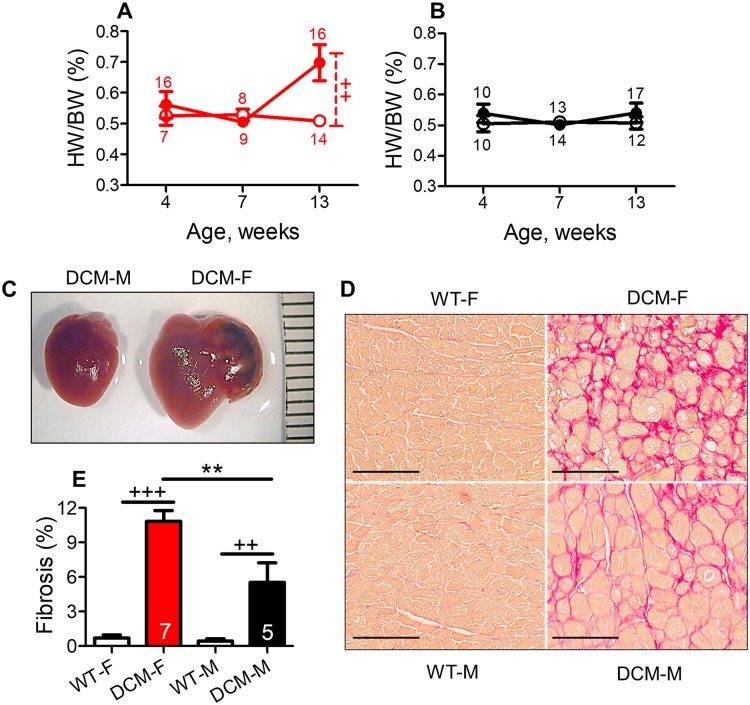
Sex differences in cardiac fibrosis and hypertrophy in DCM mice.(A) Heart weight to body weight ratio (HW/BW%) in female and (B) in male DCM and WT mice. Female or male mice with DCM are indicated by closed symbols, female or male WT controls mice by open symbols. Number of animals per group at each time point is shown. (C) Representative (scale bars, mm) image shows gross heart morphology of female and male mice with DCM at the age of 13 weeks. (D) Representative picrosirius red-stained images (scale bars, 100 μm) show collagen from heart tissue of DCM and WT, female and male mice of 13 weeks of age. Red color indicates collagen deposition. (E) Interstitial percent fibrosis was calculated in measurements from 6–12 images (scale bars, 200 μm) of the left ventricle and septum, n = 4–8 per group. WT female and WT male (open bar), DCM female (red bar) DCM male (black bar). **P<0.01 (DCM male vs. DCM female), +++P<0.001, ++P<0.01 (DCM vs. WT) mice.